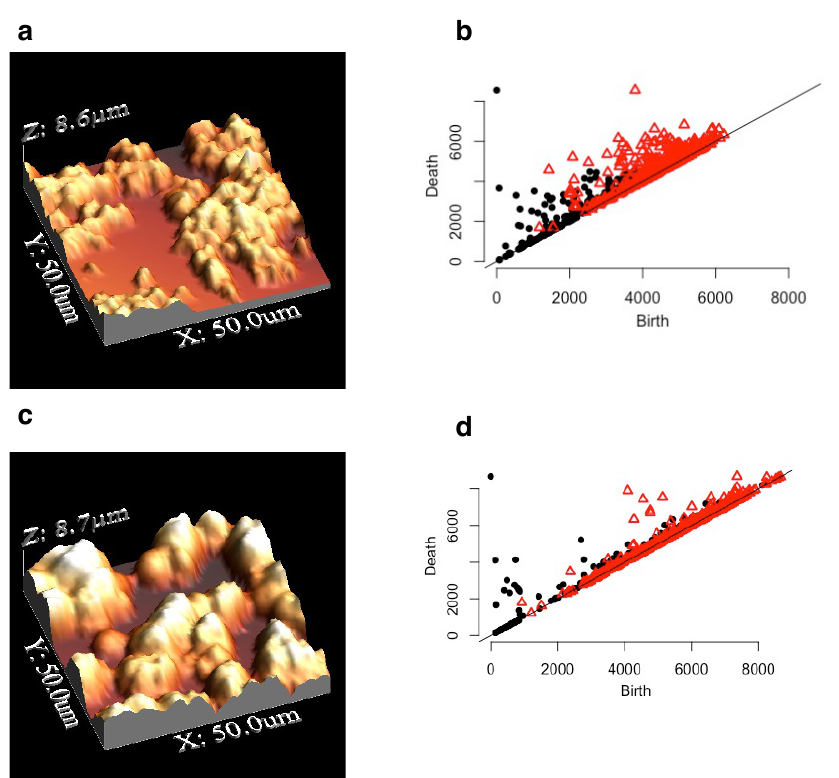
Figure 4. 50 µ m × 50 µ m AFM images of the ( a ) 2 min and ( c ) 6 min of immersion of PC and the corresponding persistence diagrams ( b , d ). The black dots indicate the persistency of zero-dimensional topological features (i.e., valleys). The red triangles indicate the persistency of one-dimensional topological features (i.e., hills). The less number of persistent features for the 6 min immersion with the increasing average height (see Table 2) proves the aggregation of micro